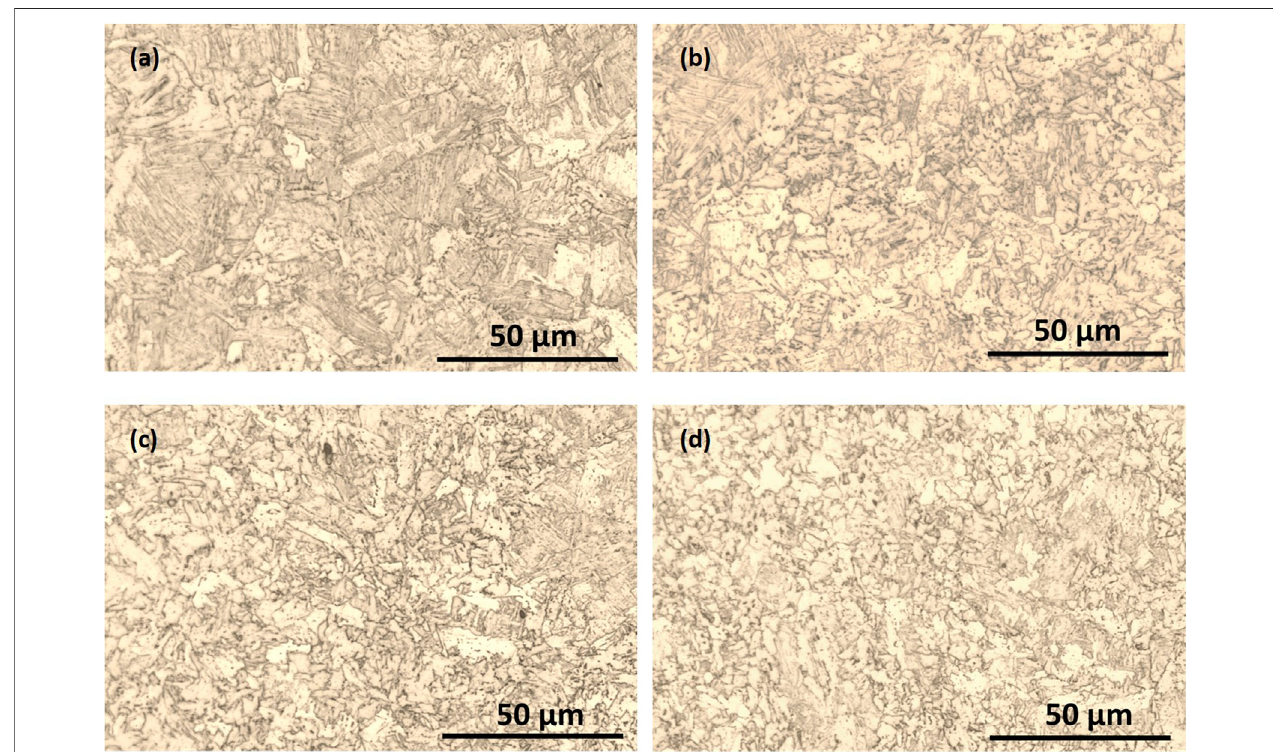
FIGURE6| TheopticalmicrostructuresofX-70steelsubjectedtointerpasstimeof20 s.Thesampleswereimmediatelywaterquenchedafterthe: (A) 1st, (B) 3rd, (C) 5th and (D) 7th passes.